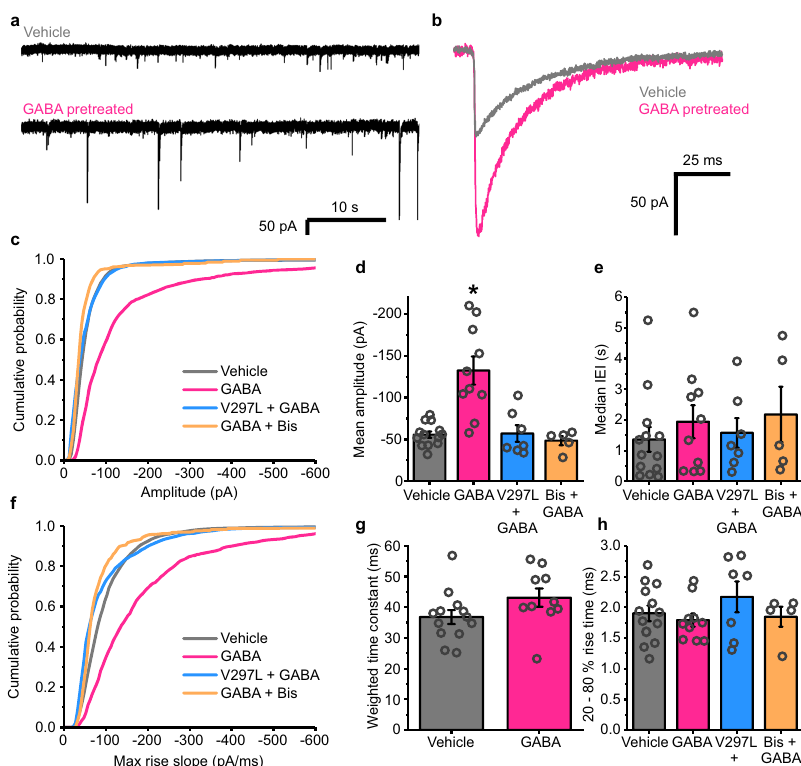
Fig. 5 Induction of iLTP by GABA requires both GABA A R desensitization and PKC activation. a Representative sIPSC traces recorded in voltage-clamp mode from neurons ~20 min after treatment with either GABA (1 mM, pink) or vehicle (black). b Average, unscaled sIPSC waveforms aligned on the rising phase. c Cumulative probability distribution of the amplitudes of all sIPSCs recorded: n = 4178 events from 13 cells, 2799 events from 10 cells, 1387 events from 7 cells, and 1440 events from 5 cells, respectively, for each construct (vehicle, black; GABA treatment, pink; α 2 V297L + GABA, blue; GABA in the presence of bisindolylmaleimide-I (Bis), orange). d Mean amplitudes of sIPSCs recorded from neurons pretreated with either vehicle or GABA: while expressing α 2 V297L , or in the presence of bisindolylmaleimide-I (Bis) (one-way ANOVA: F (3, 31) = 13.85, p = 0.0000066; Tukey test (vehicle vs GABA): p = 0.00002; Tukey test (vehicle, α 2 V297L + GABA): p = 0.99; Tukey test (vehicle vs GABA + bisindolylmaleimide): p = 0.97; n = 13, 10, 7 and 5 cells, respectively). e Median IEI for all events recorded from neurons after the indicated treatments (one-way ANOVA: F (3, 31) = 1.33, p = 0.28). f Maximum rate of rise slopes for all sIPSCs recorded. g Weighted time constants of exponential fi ts of the decay phases of sIPSCS recorded after treatment with either vehicle or GABA (two-tailed t -test: t (21) = − 1.72, p = 0.10). h Mean 20 – 80% rise times of all events recorded for each neuron in the indicated conditions (one-way ANOVA: F (3,31) = 0.97, p = 0.41). Source data are provided as a Source data fi le for Fig.